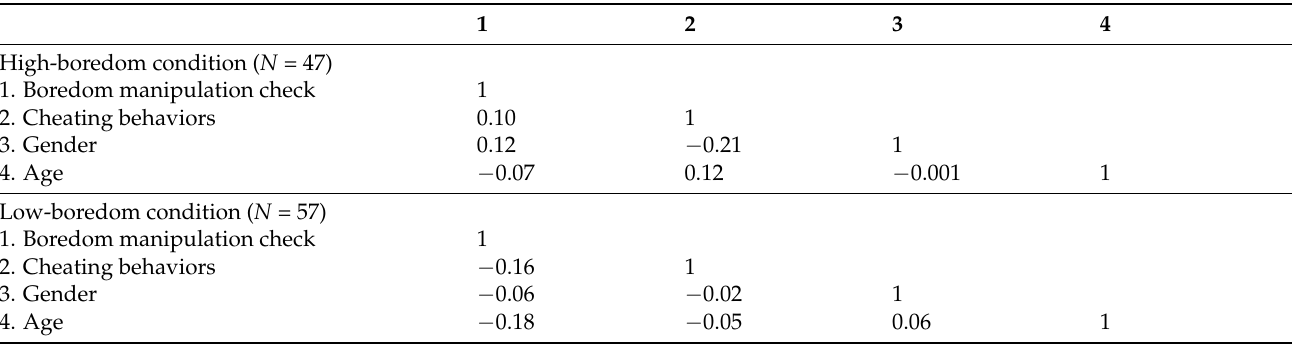
Table 2. Pearson’s correlations of all variables in Study 1 ( N =